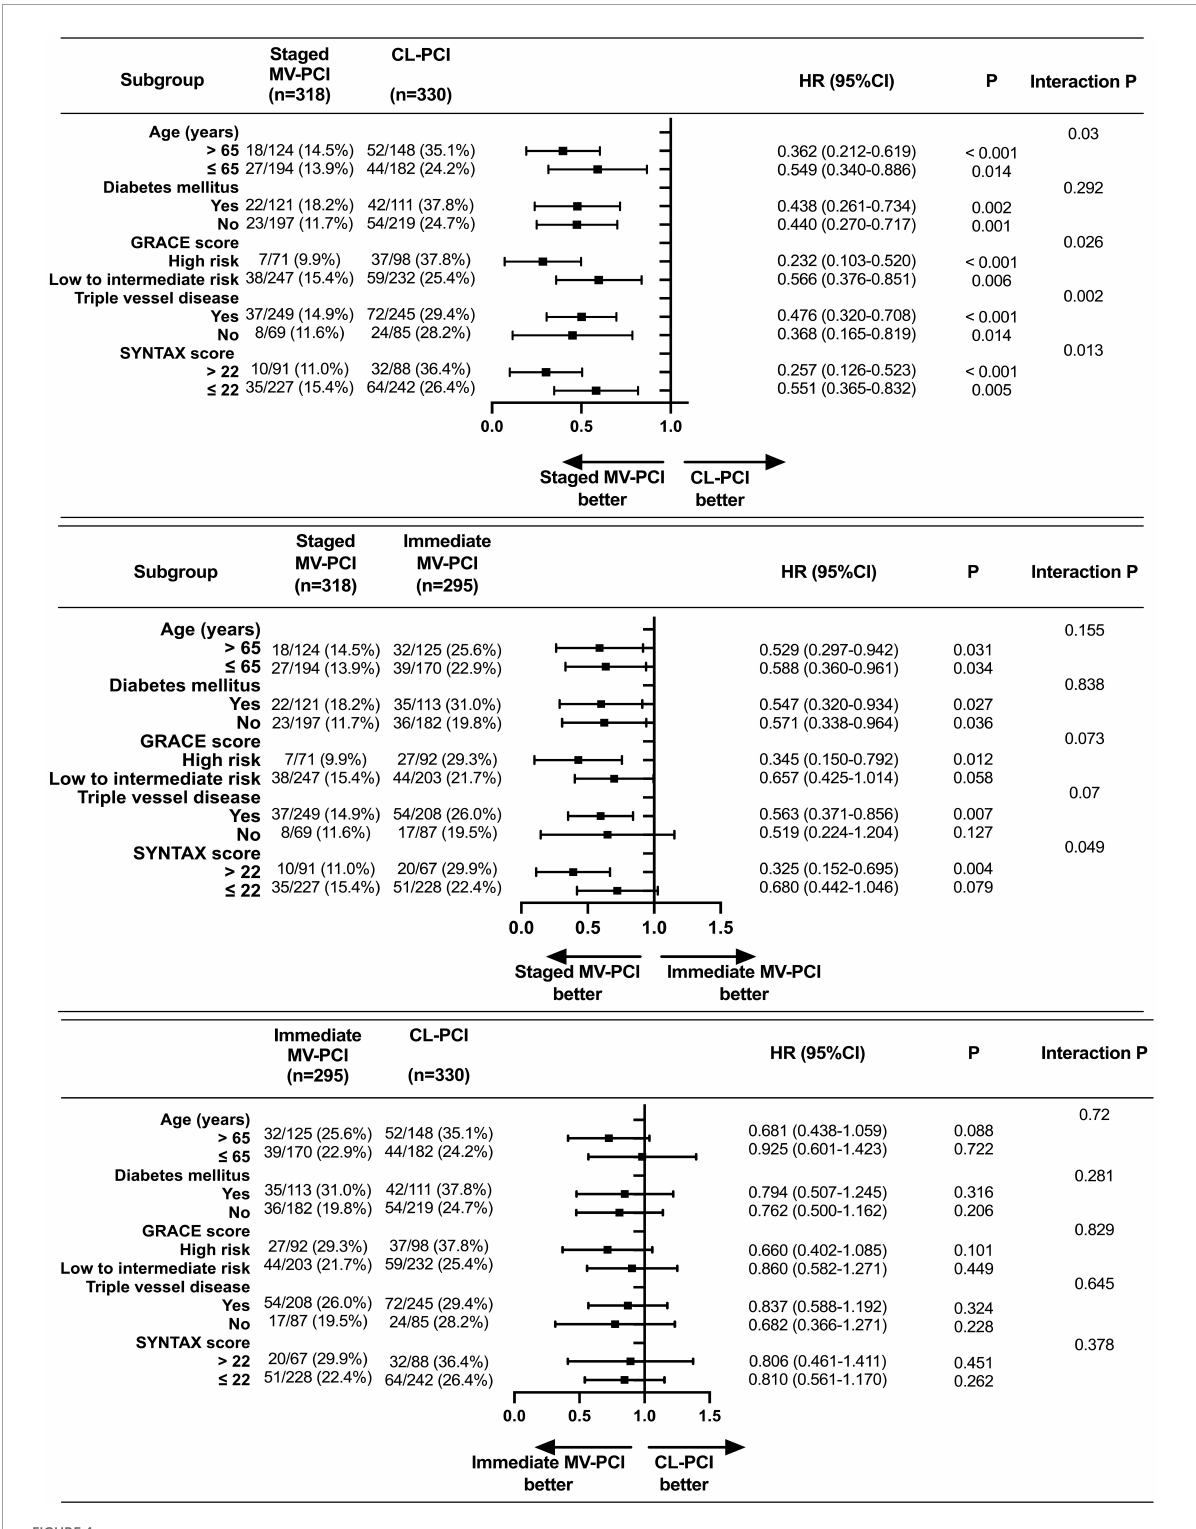
FIGURE4 Subgroup analysis on MACE. MACE, major adverse cardiac events; eGFR, estimated glomerular filtration rate; LVEF, left ventricular ejection fraction; GRACE, Global Registry of Acute Coronary Events; SYNTAX, Synergy between PCI with Taxus and Cardiac Surgery. High risk: GRACE score > 140; Low to intermediate risk: GRACE score ≤